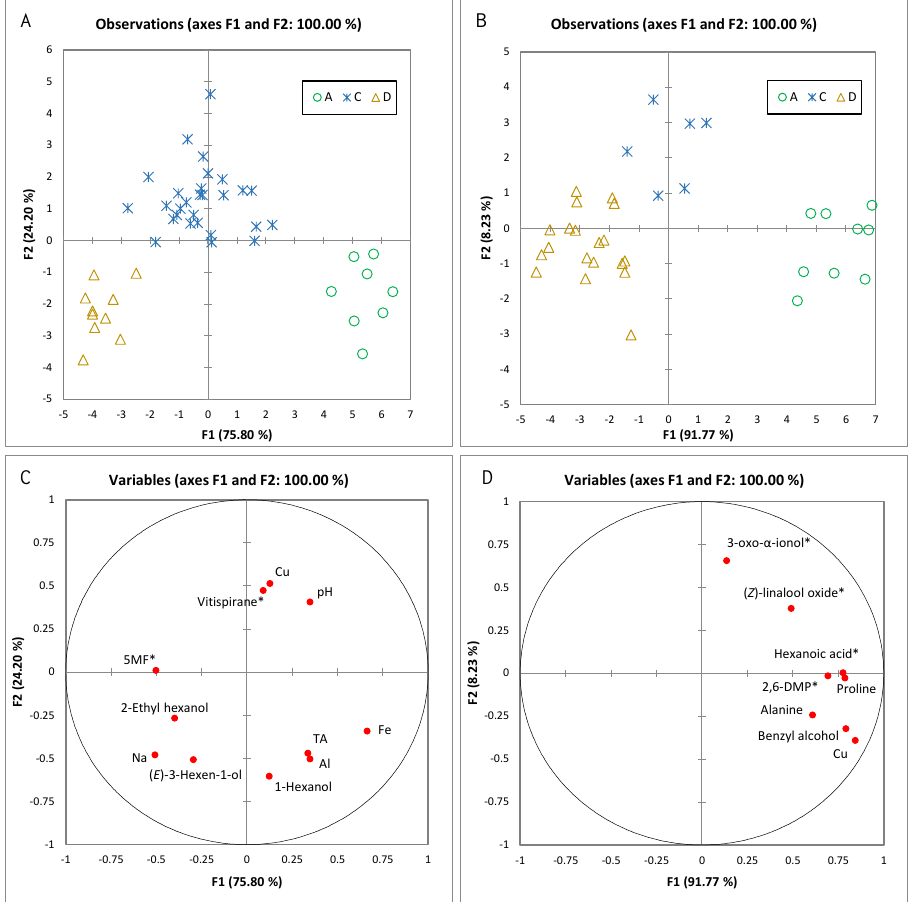
Figure 4 Figure 4. Distribution of grape samples in the two coordinate system defined by discriminant analysis showing the two canonical variables with the highest discrimination power. Scores projected onto F1 and F2 for 2015 ( A ) and 2016 ( B ) shows samples grouped according to quality grade (A, C and D). Loadings of variables used in the analysis are shown for 2015 ( C ) and for 2016 ( D ) where * denotes volatiles detected after hydrolysis of glycosides extracted from juice. Abbreviations (e.g., TA, 5-MF, 2,6-DMP) are the same as specified in the